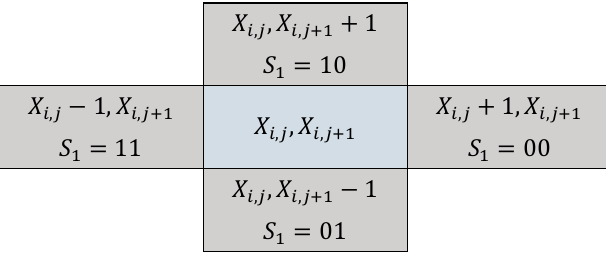
Figure 1. The cross pattern of indicating the pixel pair sets.